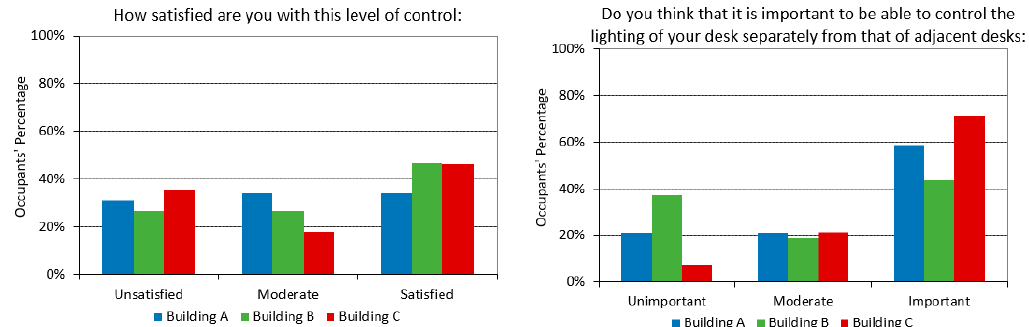
Figure 13. Results of how important is from the occupants to control the level of artificial lighting over their working plane ( left ) and in what degree ( right ).